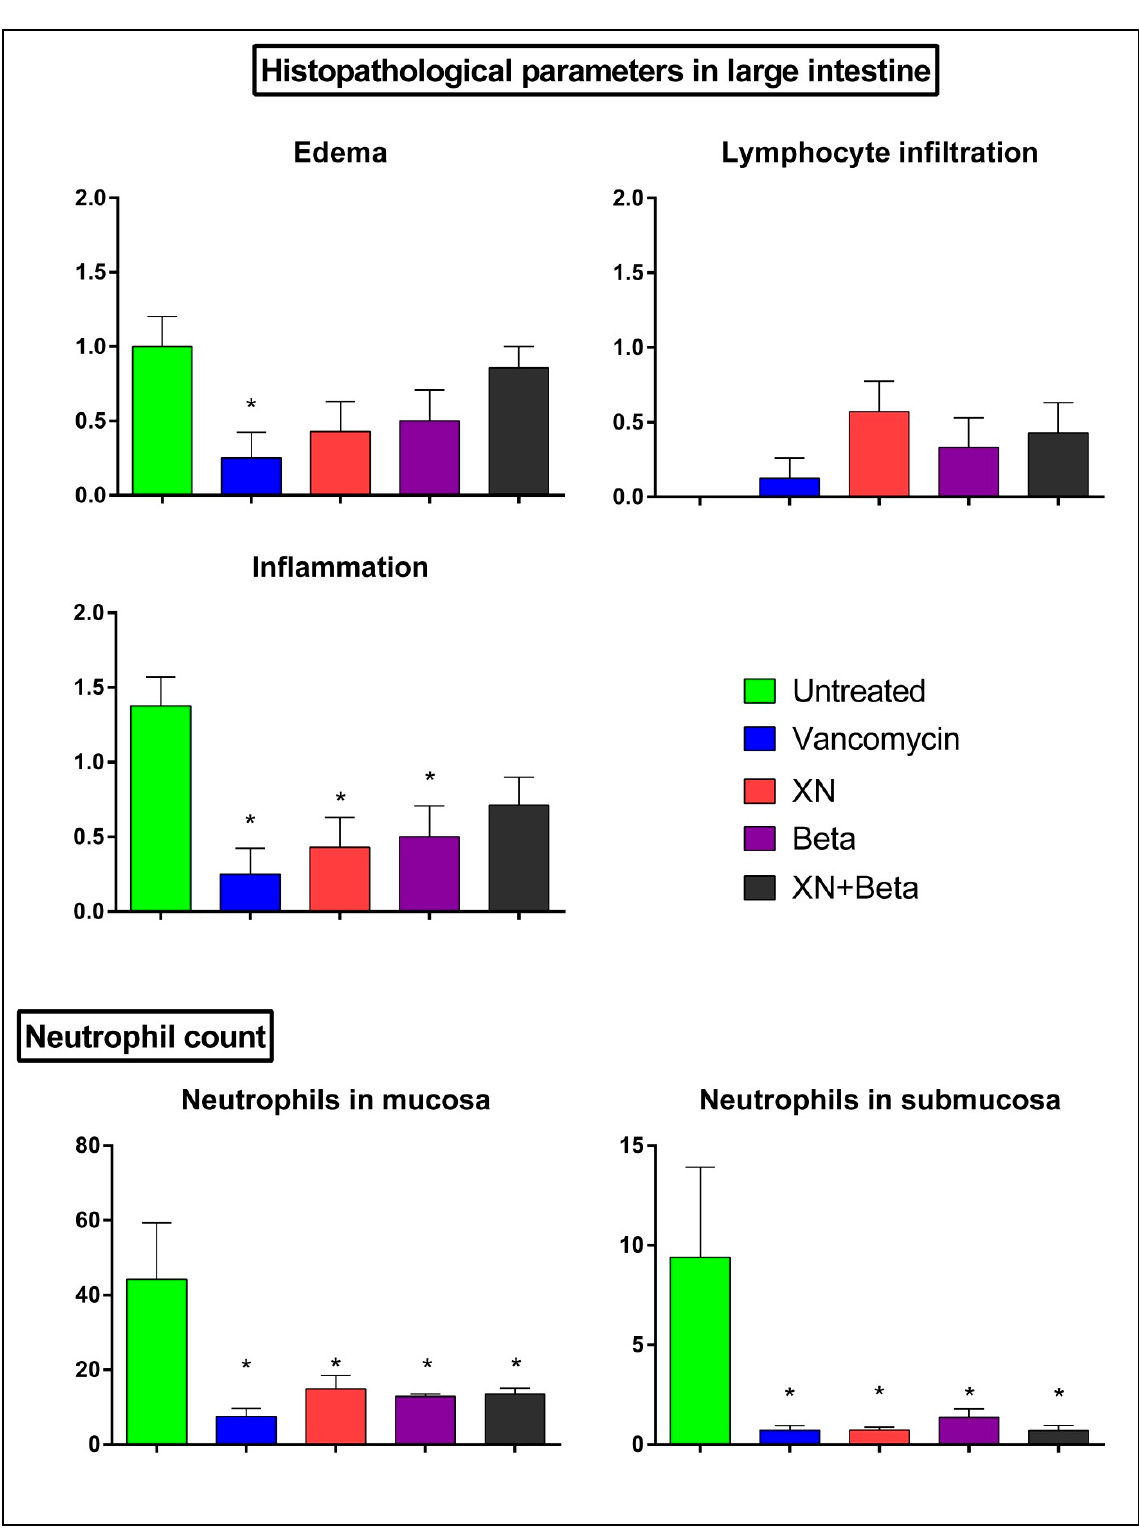
Figure 5. Histopathological analysis of the effect of treatments in large intestines of rats in the individual cohorts. Data are presented as mean ± standard deviation. * indicates significant differences compared to untreated controls ( p < 0.05).